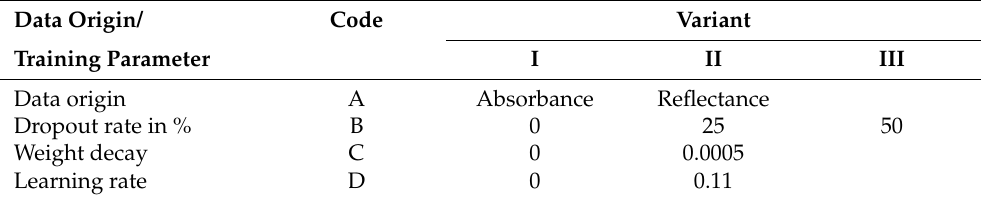
Table 2. Investigation matrix of the training parameters. For the optimization of the KidneyResNet, the influence of the data origin and the training parameters dropout rate, adaptive weights, and learning rate was studied.